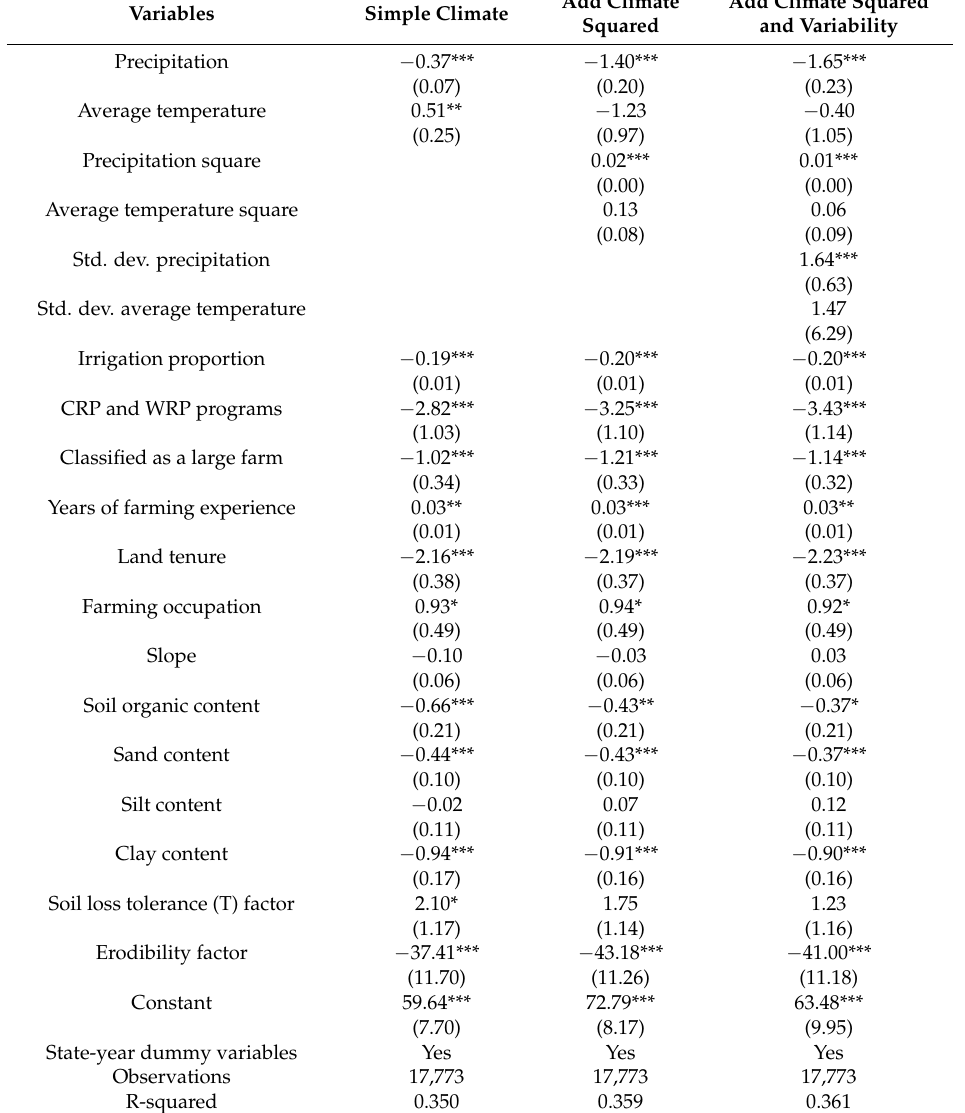
Table A1. Estimated coefficients on fallow share for three model